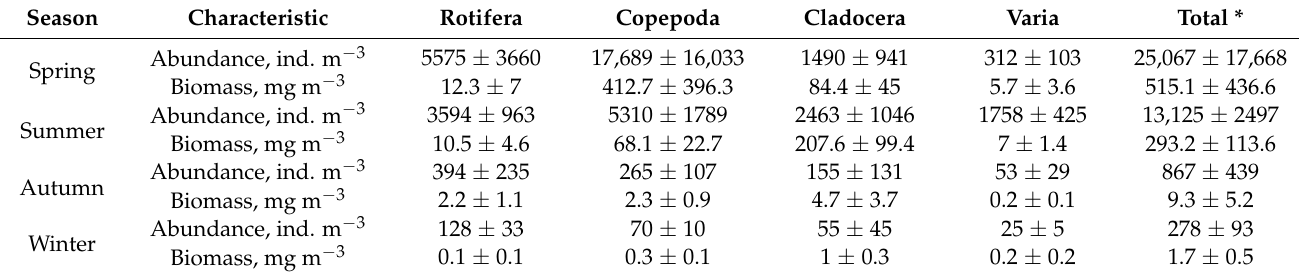
Table 2. Seasonal variation of zooplankton abundance and biomass (Average ± SE) in the Lower Dniester in 2016–2020. Season Characteristic